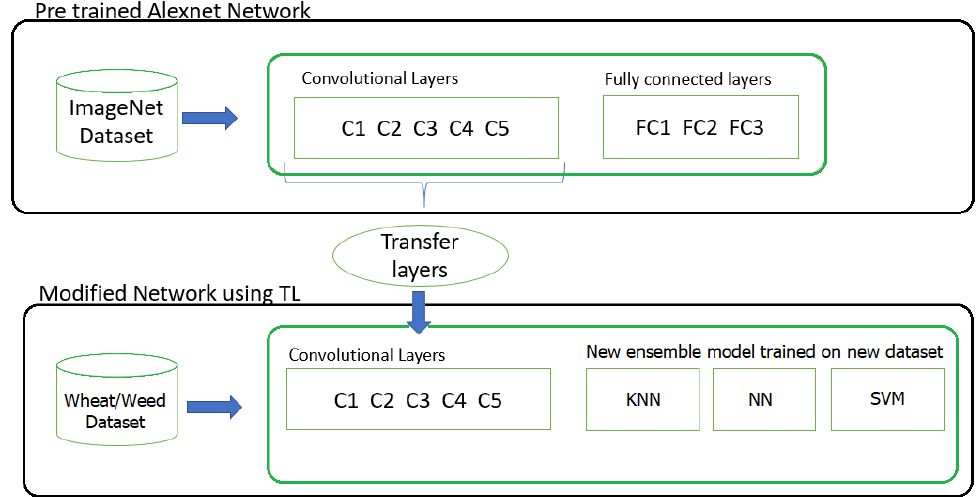
Figure 5. The transfer learning